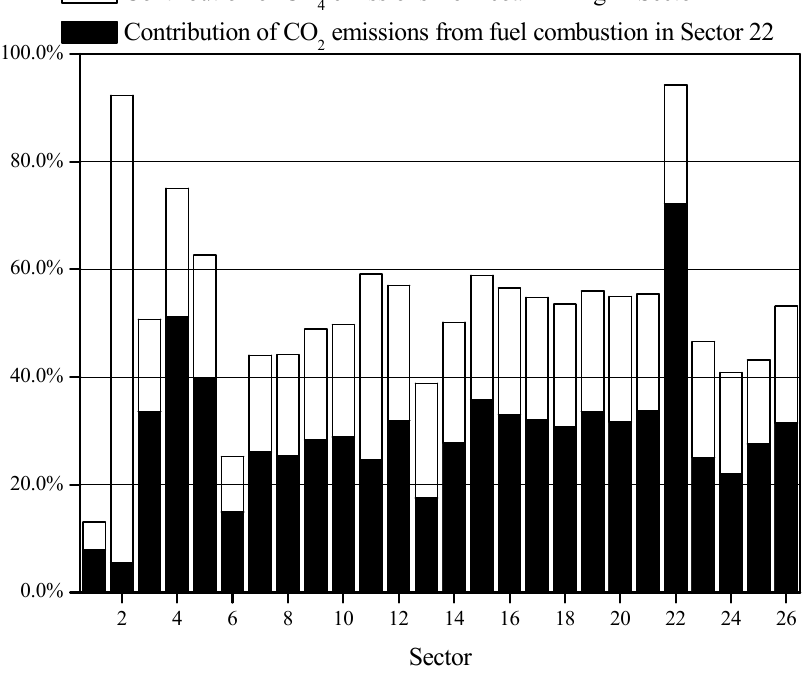
Figure 4. Contribution of direct CH emissions from fuel combustion in Sector 22 to the embodied GHG emission intensity by